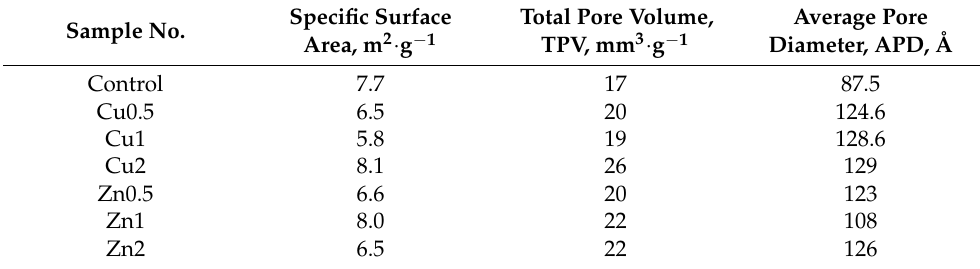
Table 3. Physical characteristics of GWC IPs synthesized with various amounts of CuO and/or ZnO replacements.